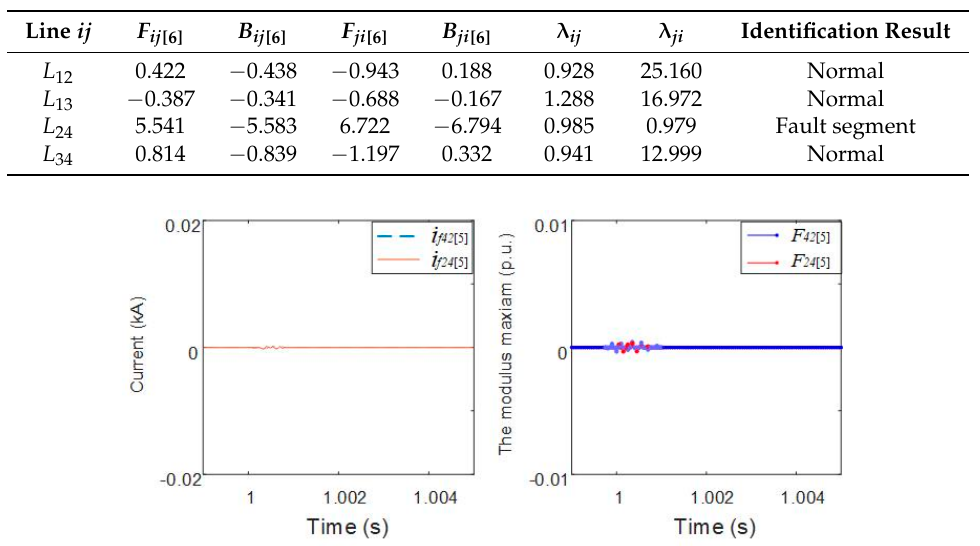
Table 3. Identification results of faulted segment for f 3 fault.